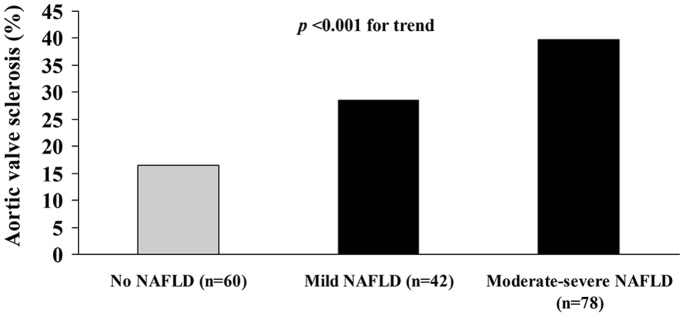
Proportion of type 2 diabetic patients with aortic valve sclerosis (AVS) in relation to the ultrasonographic severity of NAFLD.Data are adjusted for age and sex.